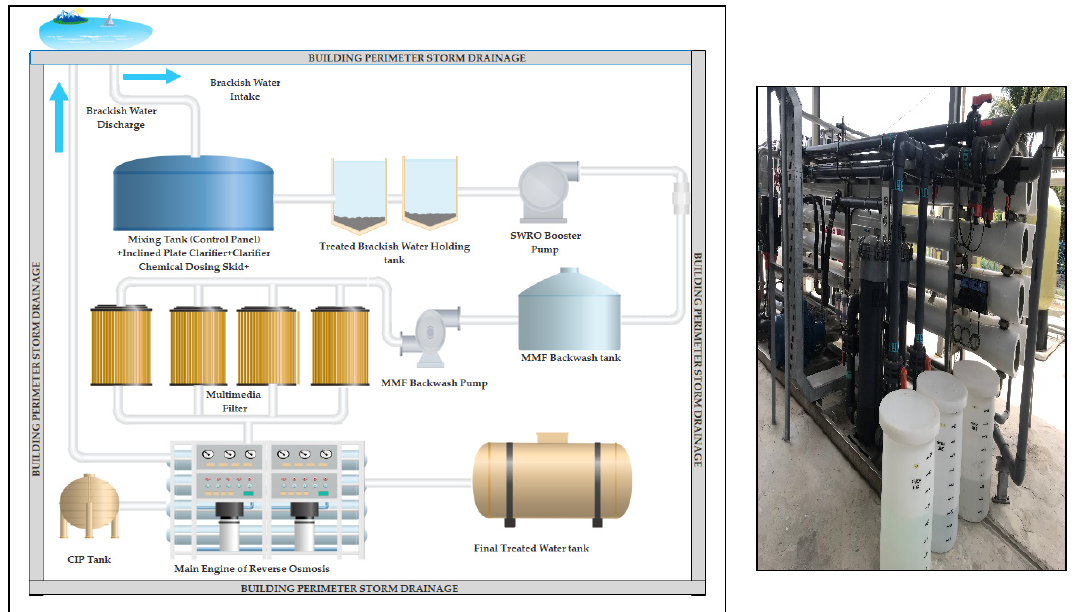
Figure 2. Photograph of reverse osmosis (RO) membrane system ( left ), and design drawings of Senok plant adapted from the original sketch plan of Advanced Membrane Technology Research Centre (AMTEC), Universiti Teknologi Malaysia (UTM) ( right